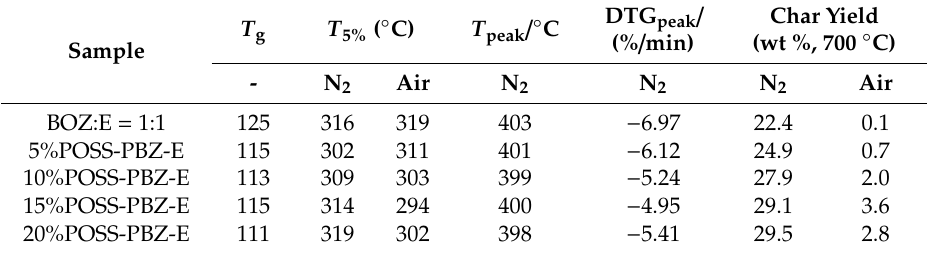
Figure 11. ( a ) TG and ( b ) DTG curves of the SPOSS-PBZ-E nanocomposites under air atmosphere. Table 3. Thermal properties of the SPOSS-PBZ-E nanocomposites.